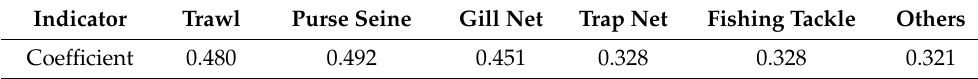
Table 1. Subsidy oil consumption coefficient of marine fishing vessels by operation type (t/Kw). Indicator Trawl Purse Seine Gill Net Trap Net Fishing Tackle Others Coefficient 0.480 0.492 0.451 0.328 0.328 0.321